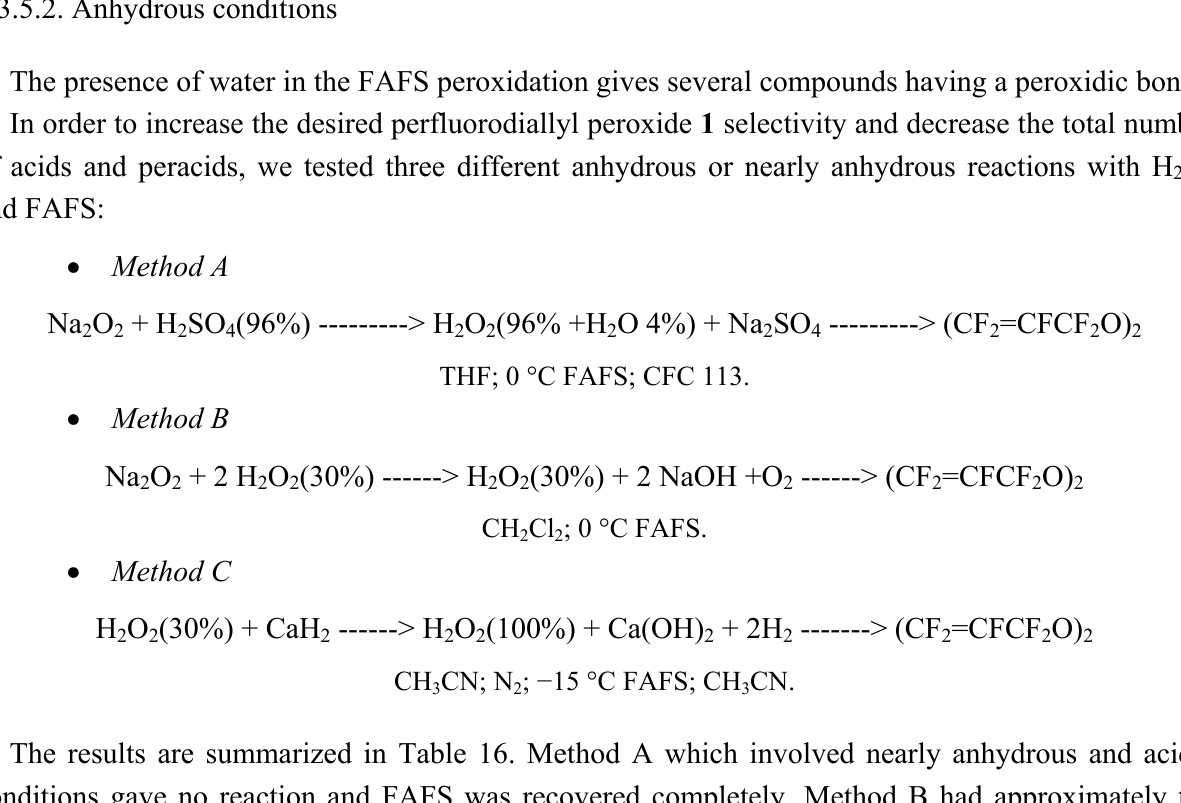
Figure 5. Sum of aqueous H